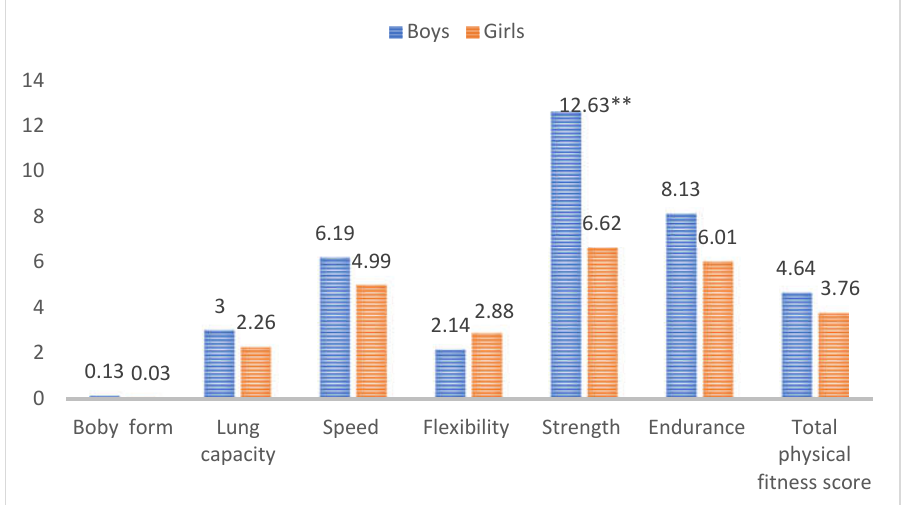
Figure 4. The independent-samples t test of physical fitness scores progress between different gender. Note: ** means at the alpha 0.01 level.